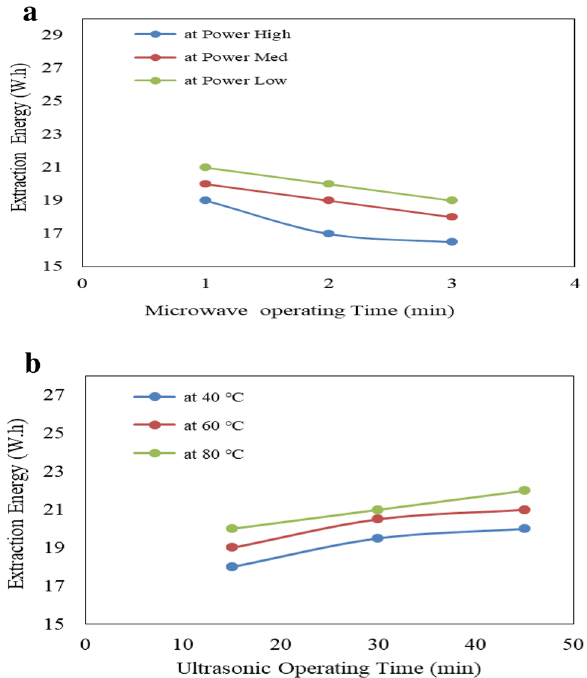
Figure 9. ( a ) Effect of microwave condition on oil extraction energy. ( b ) Effect of ultrasonic condition on extraction